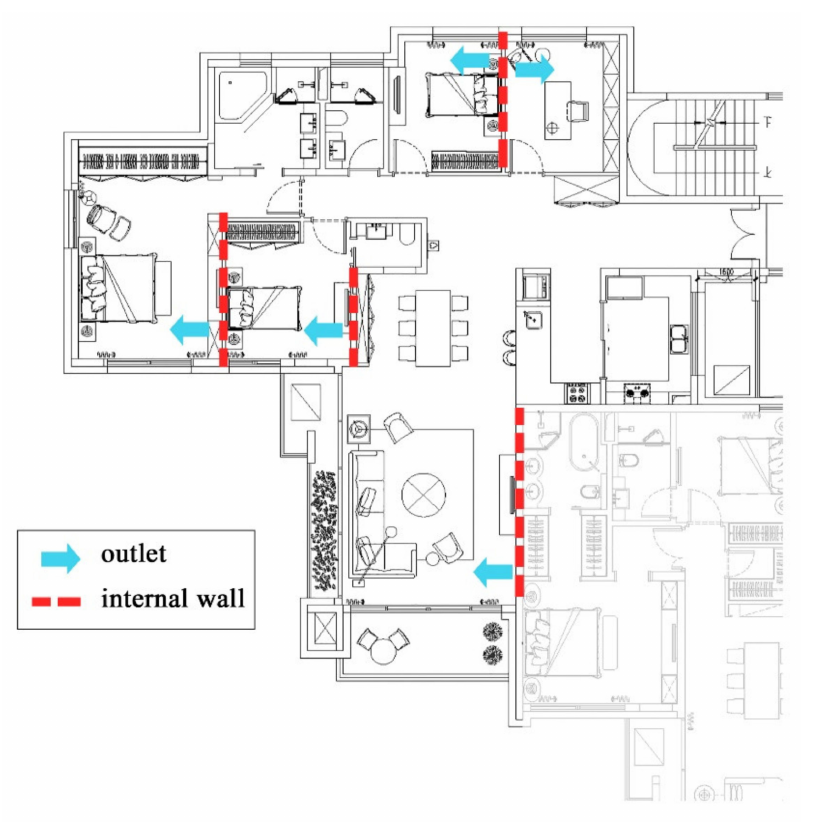
Figure 7. The layout of the internal walls and the outlets.